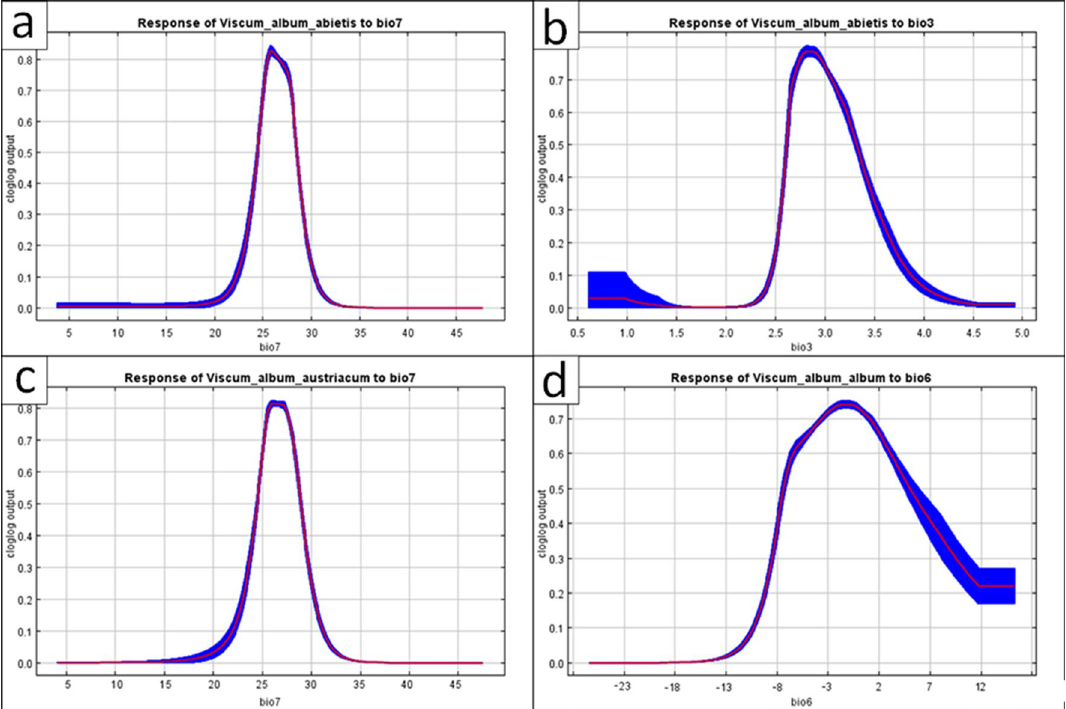
Figure 1. Response of Viscum album subspecies to the most important environmental variables (above 30% of contribution); ( a ) response of V. album subsp. abietis to temperature annual range, ( b ) response of V. album subsp. abietis to isothermality, ( c ) response of V. album subsp. austriacum to temperature annual range, ( d ) response of V. album album to the minimum temperature of the coldest